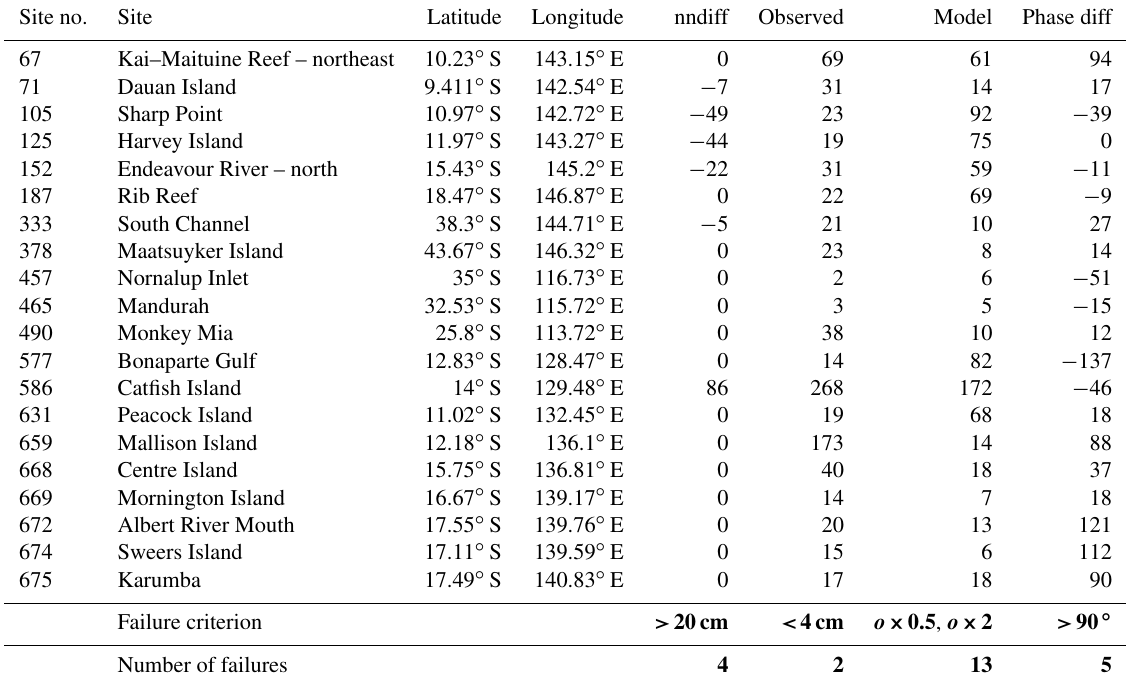
Table 1. Blacklisted tide gauges. Tests are on the nearest-neighbour difference ( cm ) , the observed M2 amplitude ( cm ) , and the model M2 amplitude ( cm ) and phase relative to the observed values. Failure criteria for these tests and the number of sites failing the tests are given at the bottom of the